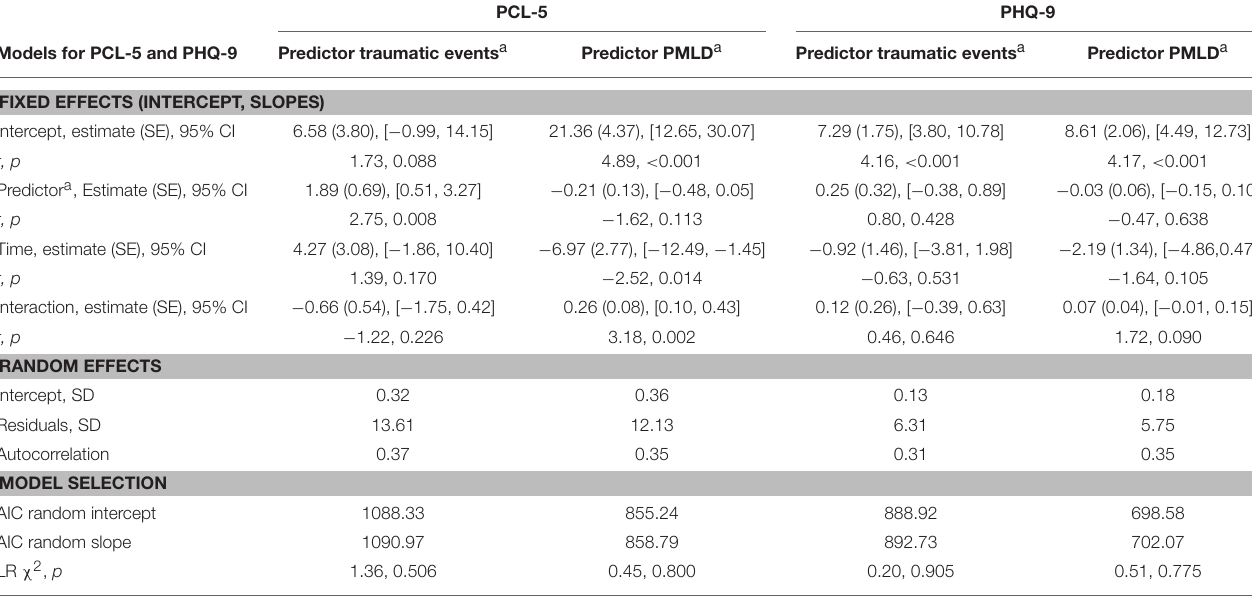
TABLE 3 | Parameter estimates for linear growth model—PCL-5 and PHQ-9. PCL-5 PHQ-9 Models for PCL-5 and PHQ-9 Predictor traumatic events a Predictor PMLD a Predictor traumatic events a Predictor PMLD